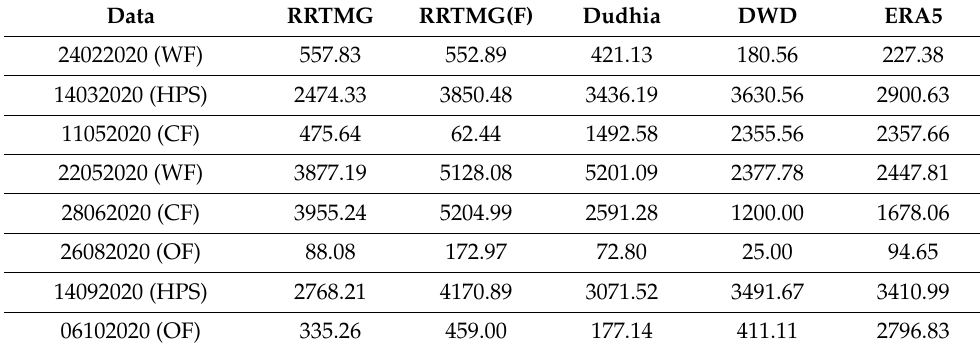
Table 14. Summary of daily values of direct radiation at Rostock-Warnemünde station [W · m − 2 ].